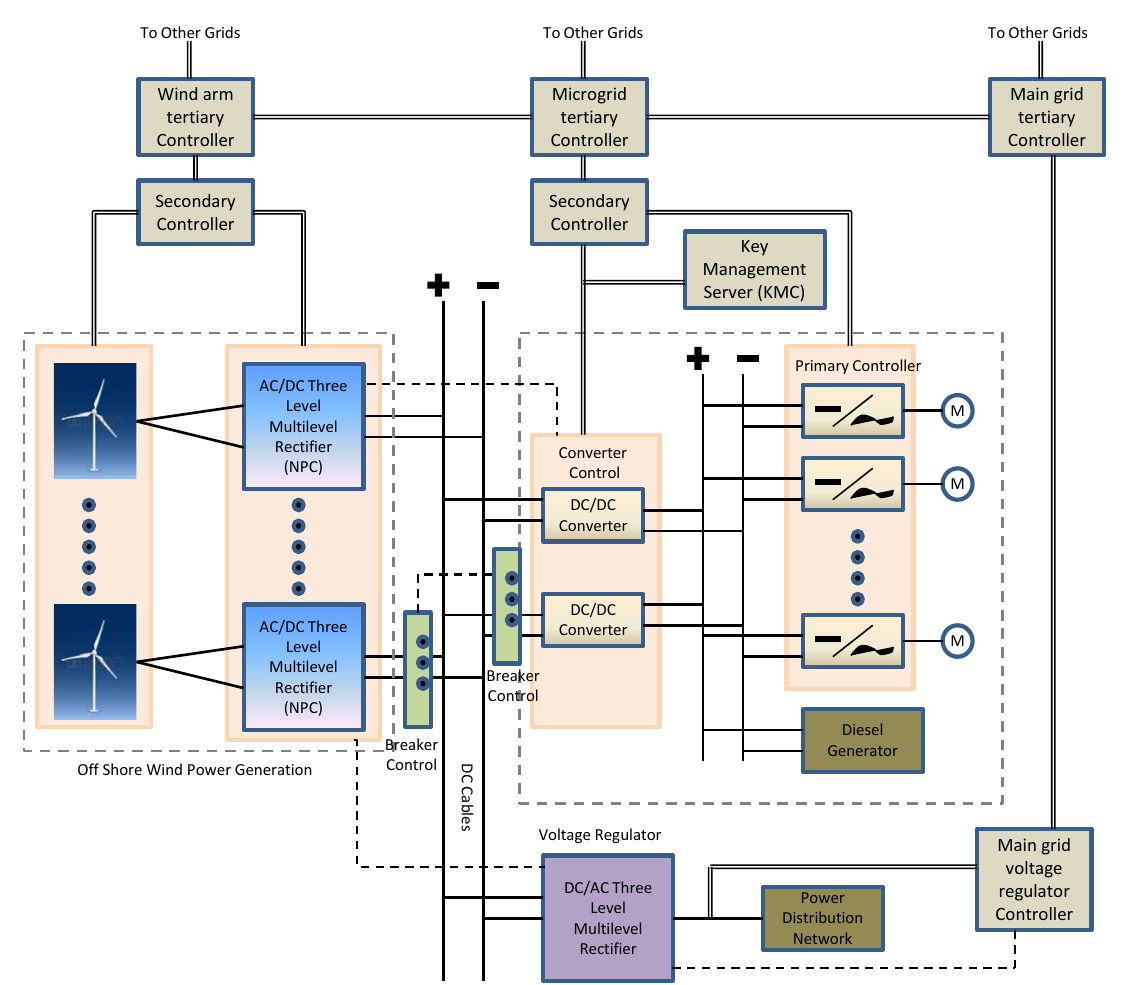
Figure 2. Offshore platform microgrid control and communication